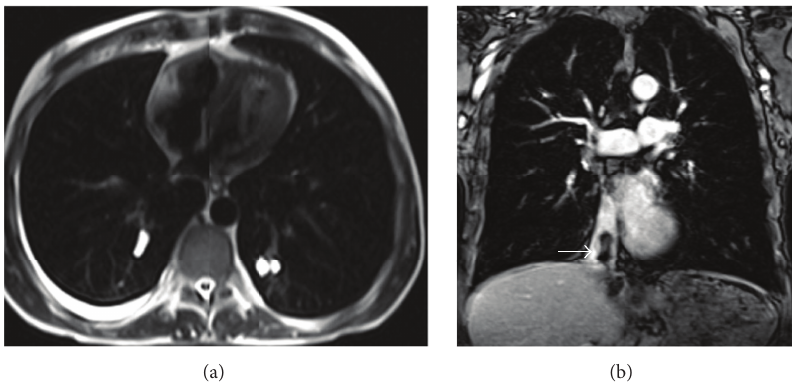
Figure 4: Axial T2-weighted MRI shows hyperintense cystic nodules in the lower lobe segmental pulmonary arteries bilaterally (a). Contrast- enhanced T1-weighted Vibe sequence coronal MRI shows contrast filling defect within the IVC due to ruptured liver hydatid cyst (b)